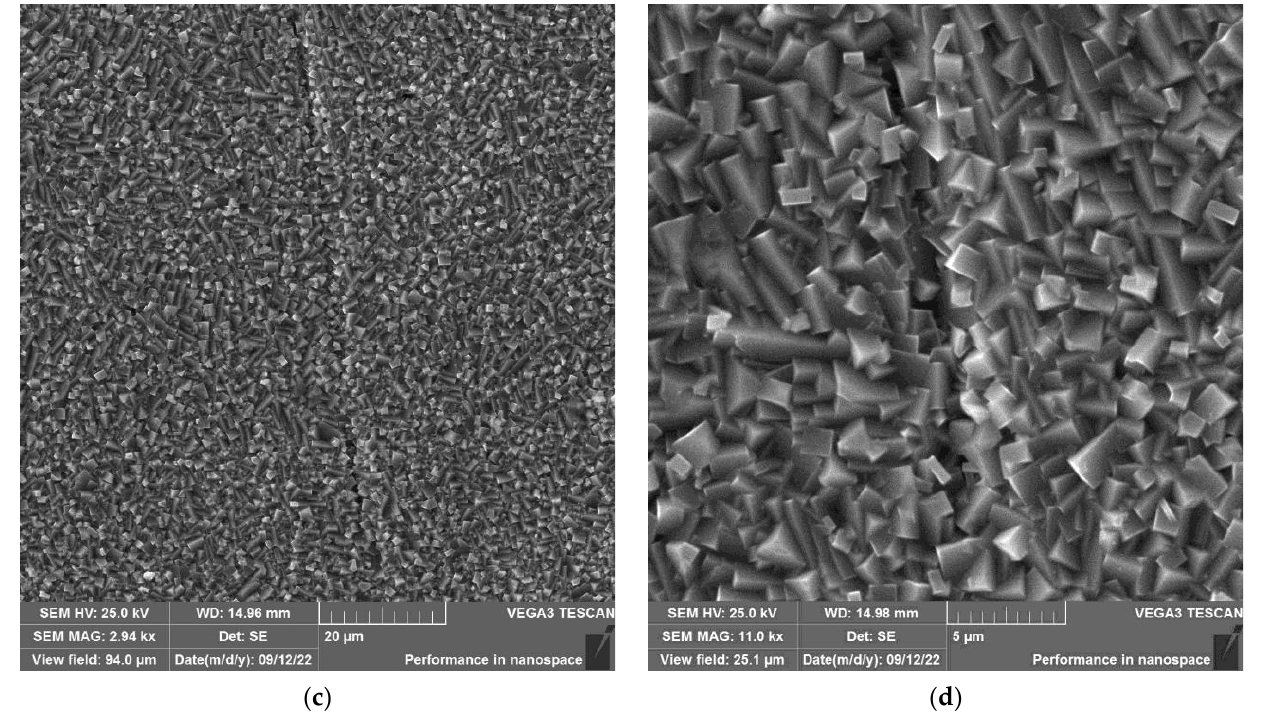
Figure 8. Surface of disk specimen № 4 (T irr = 390 °C, Table 4) at different magnifications after autoclave SCC tests with a load value of 605 N (before crack opening loading).